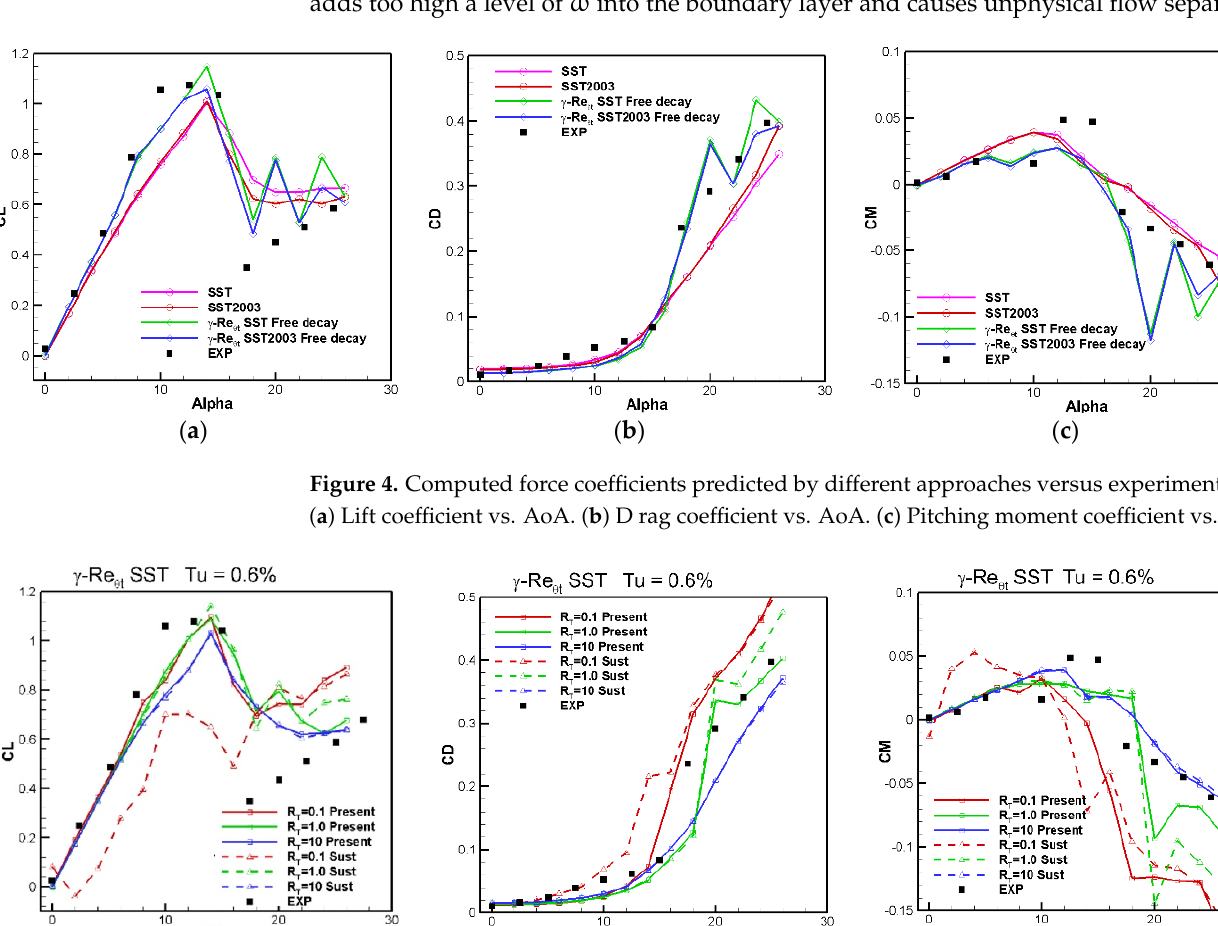
Figure 5. Computed force coefficients predicted with sustaining term from [4] and present approach using γ -Re θ t SST model. ( a ) Lift coefficient vs. AoA. ( b ) Drag coefficient vs. AoA. ( c ) Pitching moment coefficient vs. AoA.